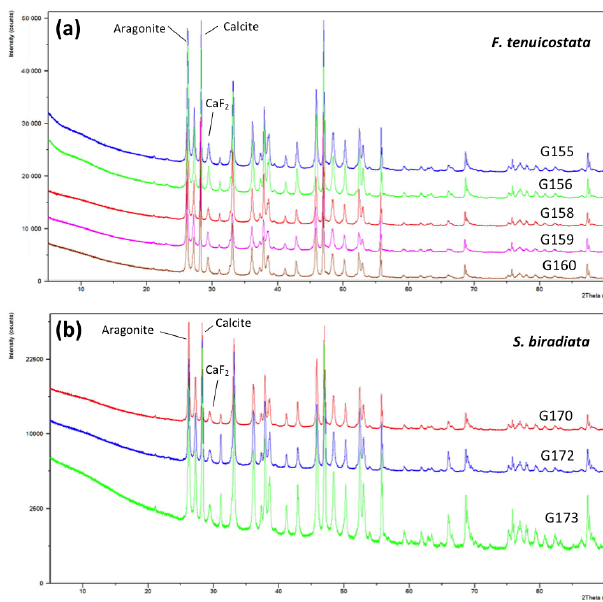
Figure 3. The X-ray diffraction patterns of specimens of Fulvia tenuicostata (a) and Soletellina biradiata (b) . Each XRD pattern is offset from the next (along the y axis) to show the consistency of the diffraction peak positions. The sample ID is indicated to the right of each diffraction pattern. Intensity is relative. Note: G154, G157 and G172 were not analysed using XRD because the sample weight was too low. The main diffraction peaks indicated for each phase identified aragonite, calcite and calcium fluorite CaF 2 .